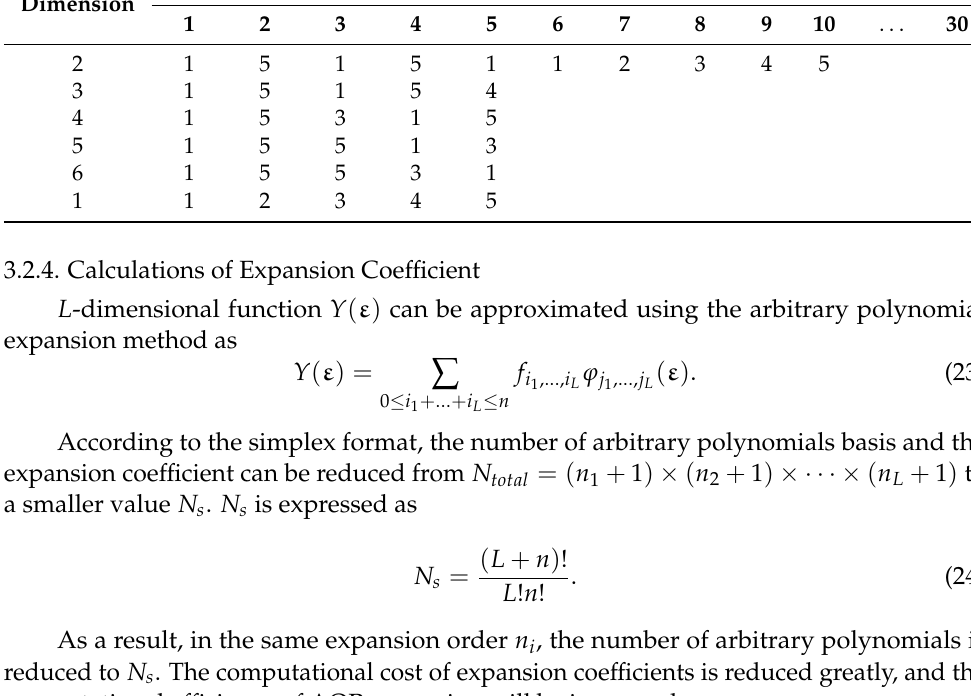
Table 3. The first design matrix of position for k = 5 and L = 6.